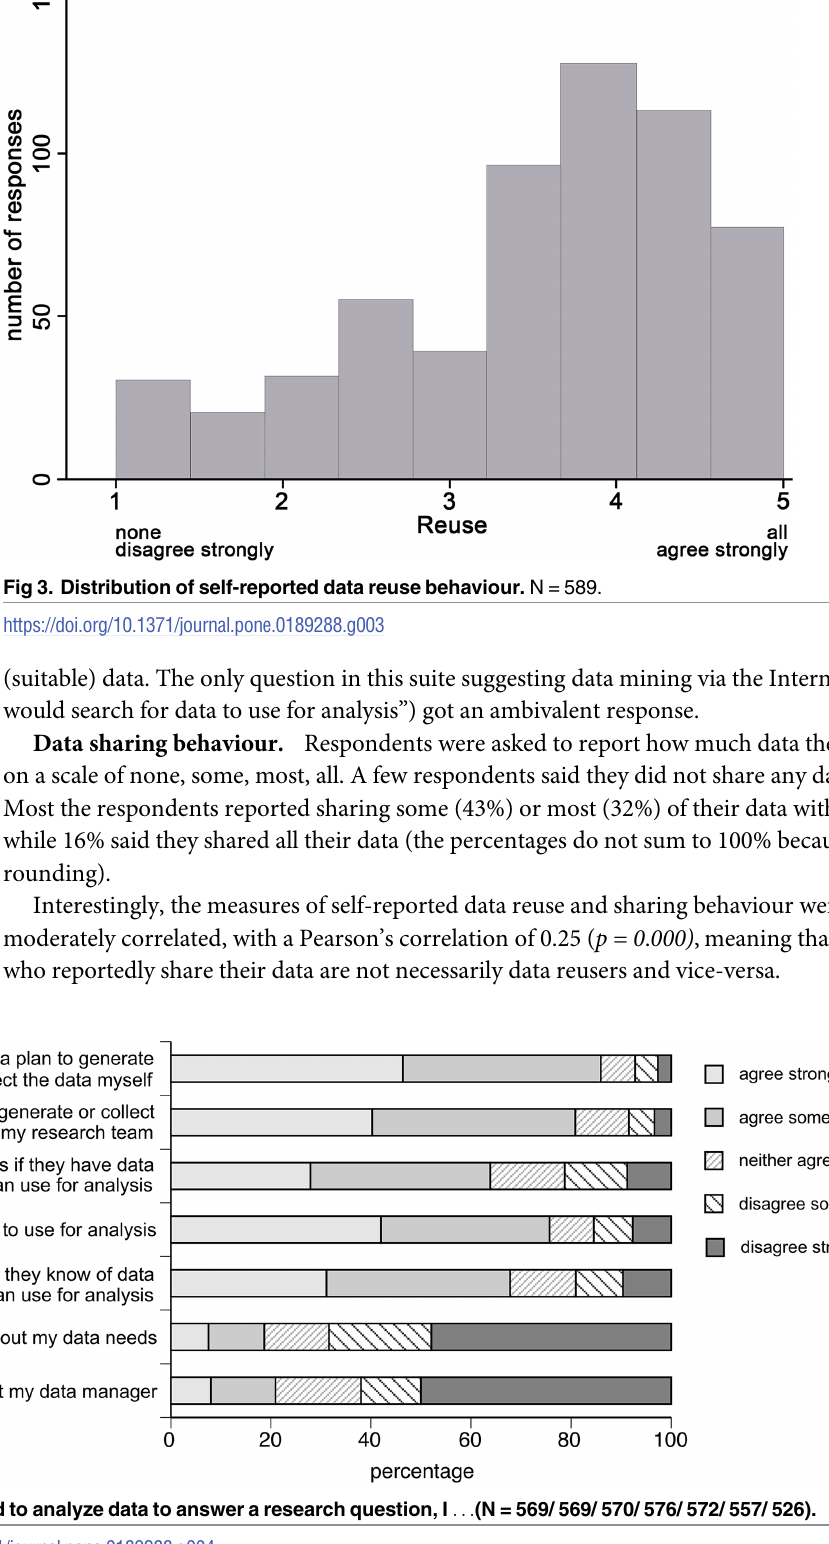
PLOS ONE | https://doi.org/10.1371/journal.pone.0189288 December27,